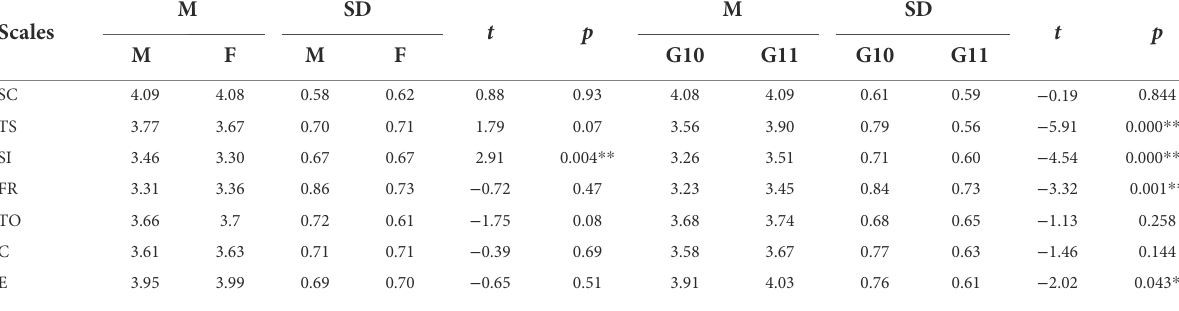
TABLE 4 The results of gender and grade differences in English classroom environment.